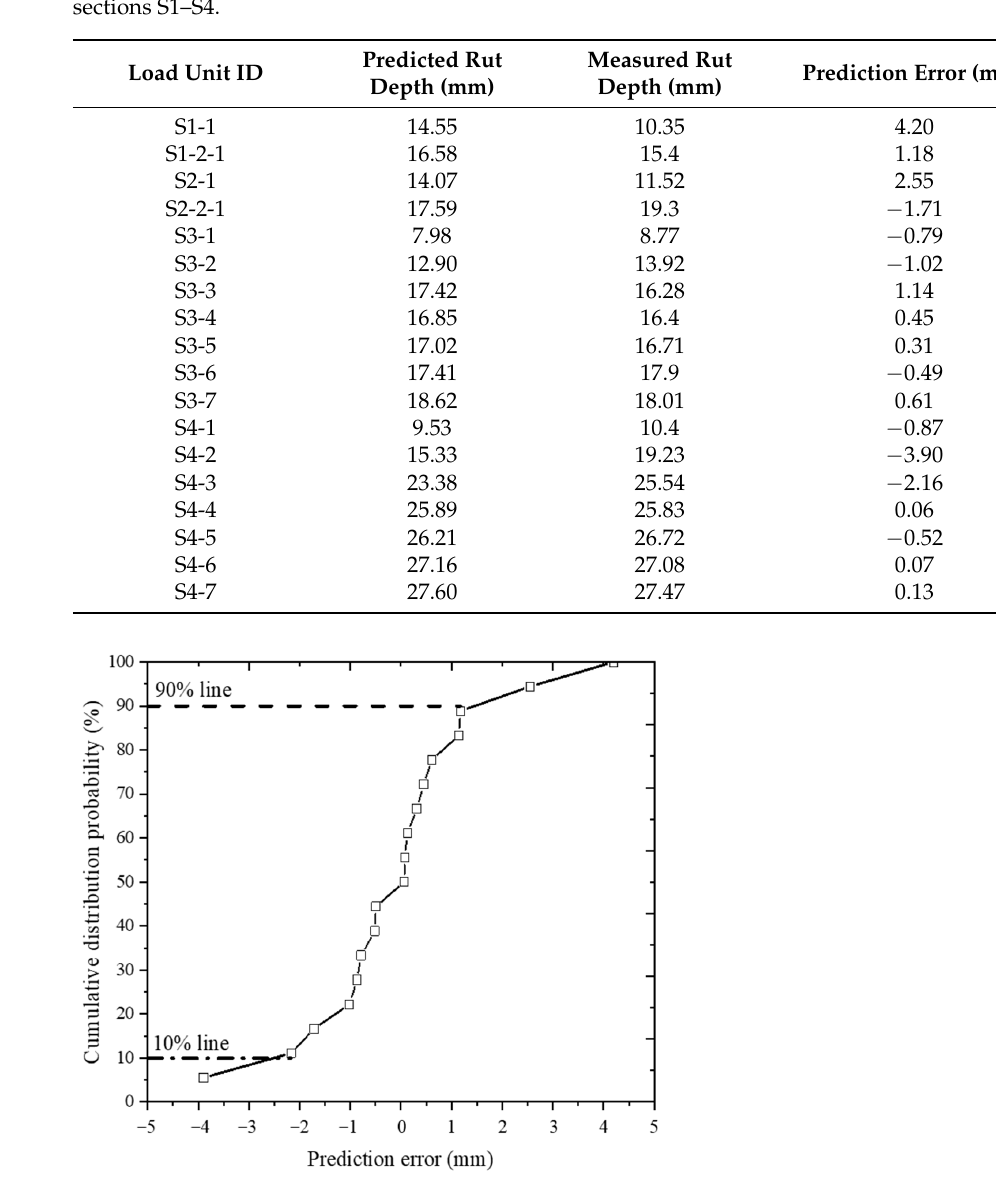
Figure 9. Cumulative probability distribution curve of the rut depth prediction error of all load units.